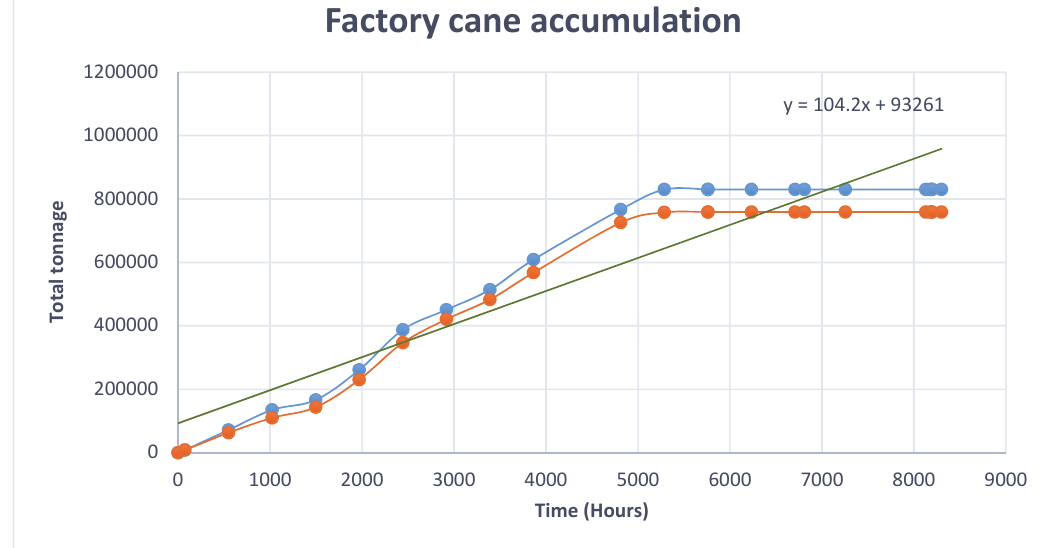
Fig. 16 (b). The operating time and total deliveries without scheduling theory